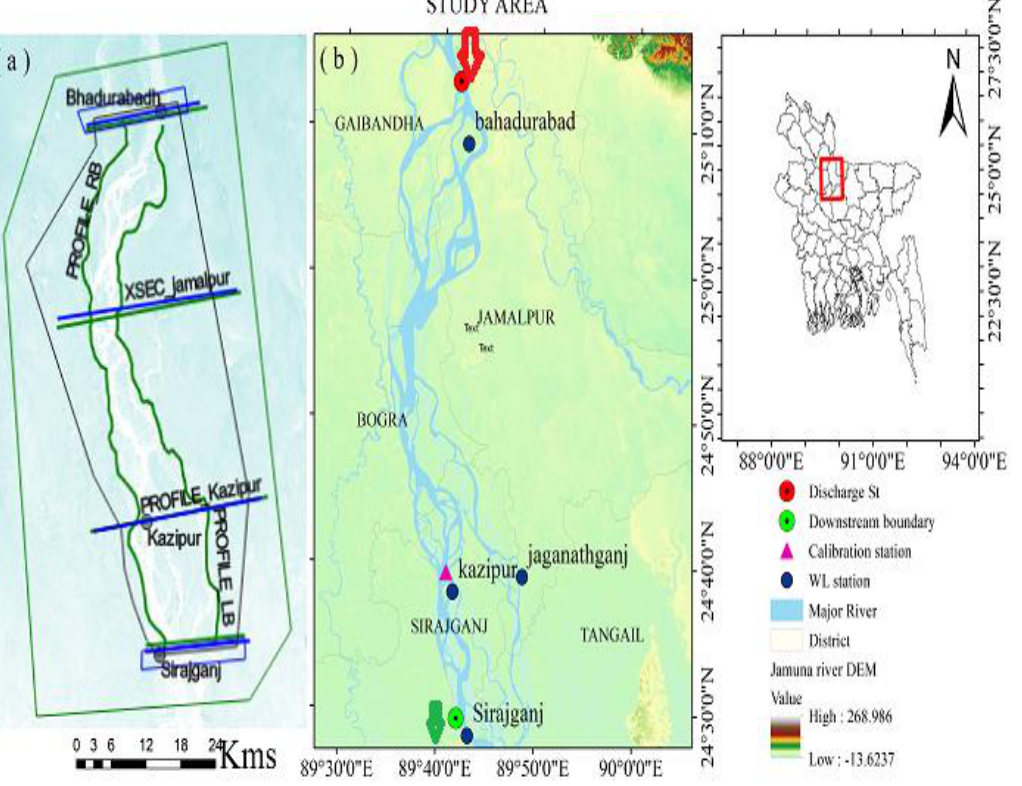
Fig. 1. Study area showing Jamuna river reach